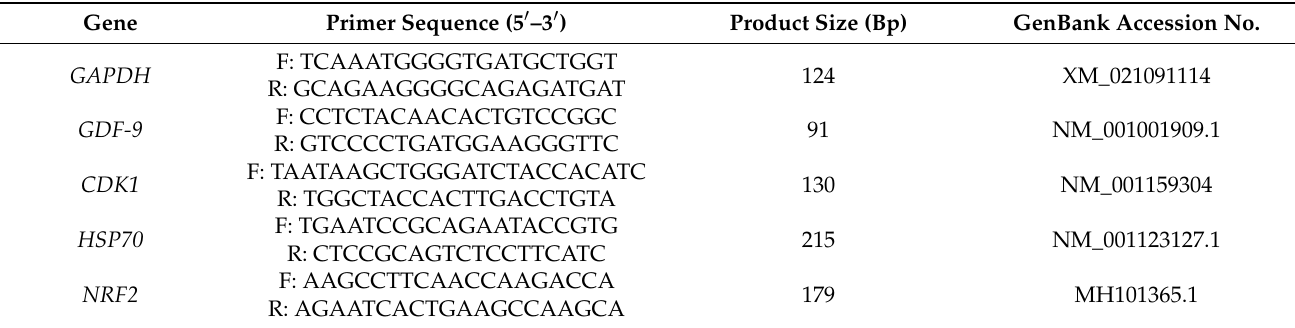
Table 1. Primer sequences for RT-qPCR analysis.